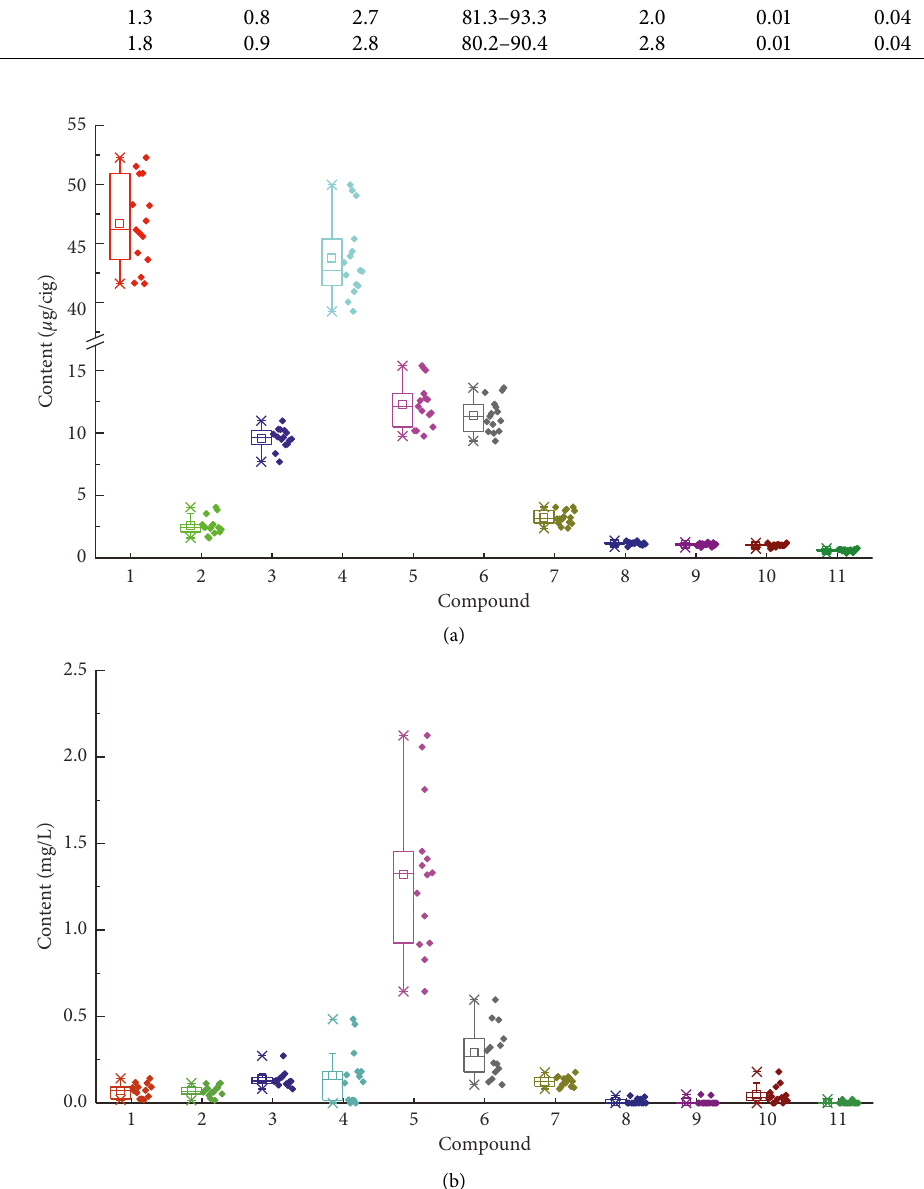
Figure 3: Box plots of phenolic compounds contents in mainstream smoke (a) and smokers’ saliva (b) for different cigarettes. The numbers of compounds are the same as in Table